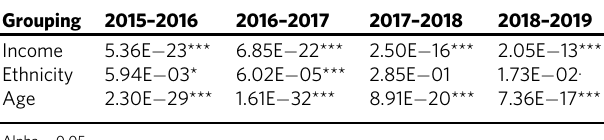
Table 3 P -values from two-tailed Mood ’ s Median tests on median in fl ection temperatures of income, ethnicity, and age